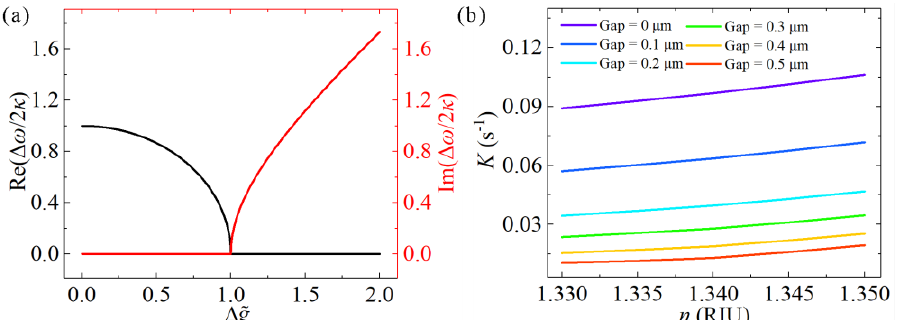
Figure 1. ( a ) Real and imaginary parts of ∆ ω / 2 κ as a function of ∆ ˜ g . The di ff erence between the eigenfrequencies changes from purely real to purely imaginary at ∆ ˜ g = 0. ( b ) Coupling coe ffi cient K as a function of refractive index under di ff erent gaps.